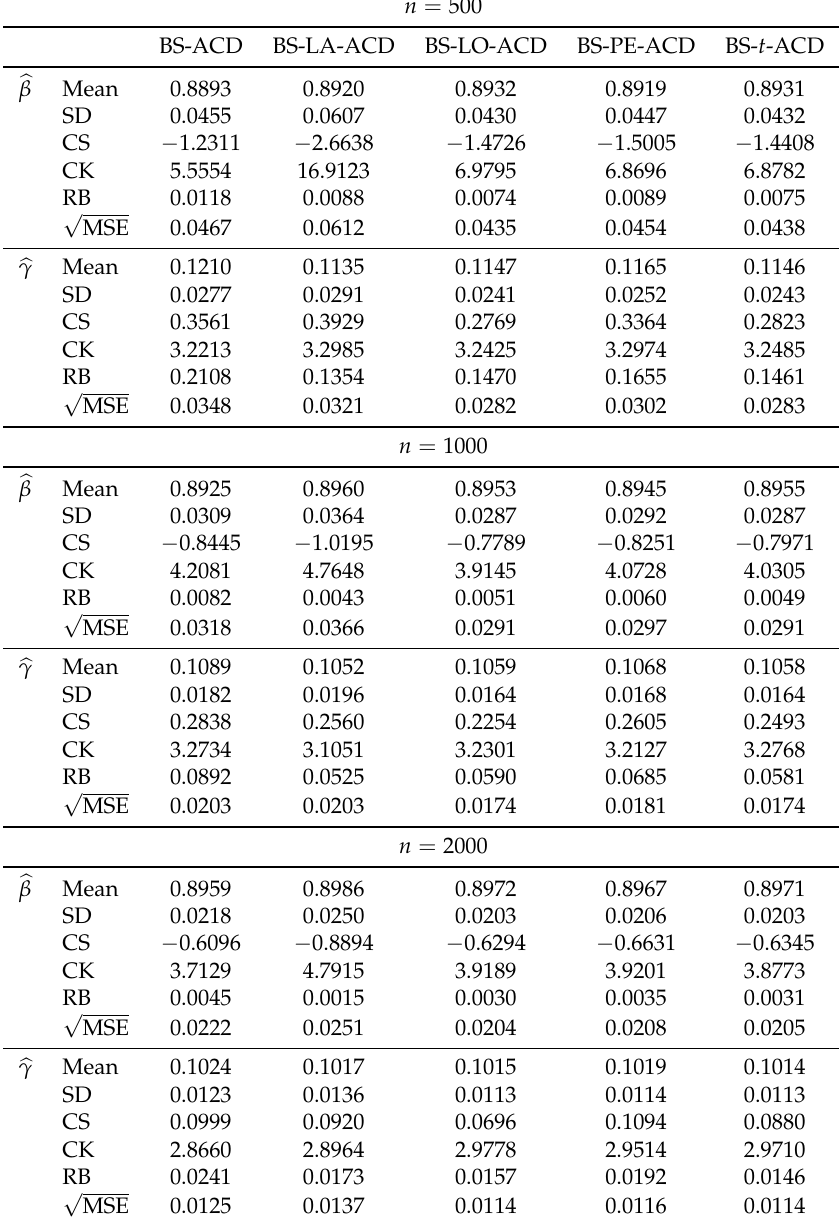
Table 2. Results of the Monte Carlo (MC) experiments based on the generalized gamma